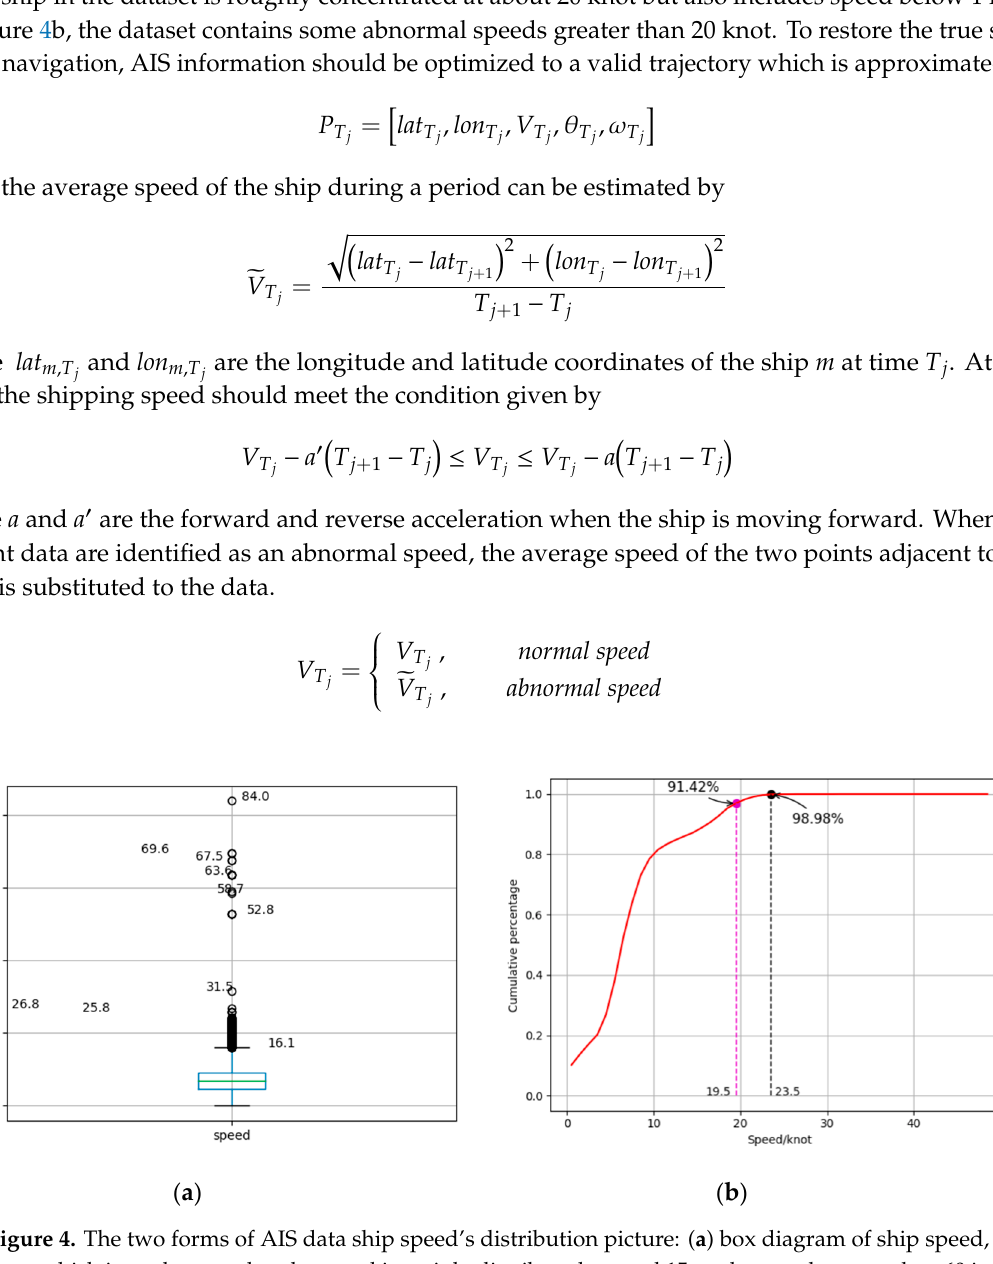
Figure 5. Plot of the comparison of the original trajectory and optimized trajectory of a same vessel. 3.2. Cluster Analysis This section introduces the trajectory clustering model based on the AIS data that were previously processed to generate regular shipping route patterns. The DBSCAN algorithm is a density-based point or line clustering algorithm that was introduced by Ester et al. [22]. The main advantage of this algorithm is that arbitrarily shaped clusters can be identified. By applying the DBSCAN algorithm, lines are mainly divided into three types: density-connected lines, outliers, and core lines. A line is generally classified as a core line if a minimum number of MinPts lines are included within a distance Eps, and the lines that are density connected with others are regarded as the same cluster, while points which are not density connected are regarded as outliers [23]. The optimized trajectory set is generated by the DBSCAN trajectory clustering, and trajectories are roughly classified into incoming waterway, crossing waterway, and north–south routes. This allows us to extract the area of each trajectory to be predicted, and then each classified waterway is used as a dataset separately for subsequent data processing, as shown on Figure 6.